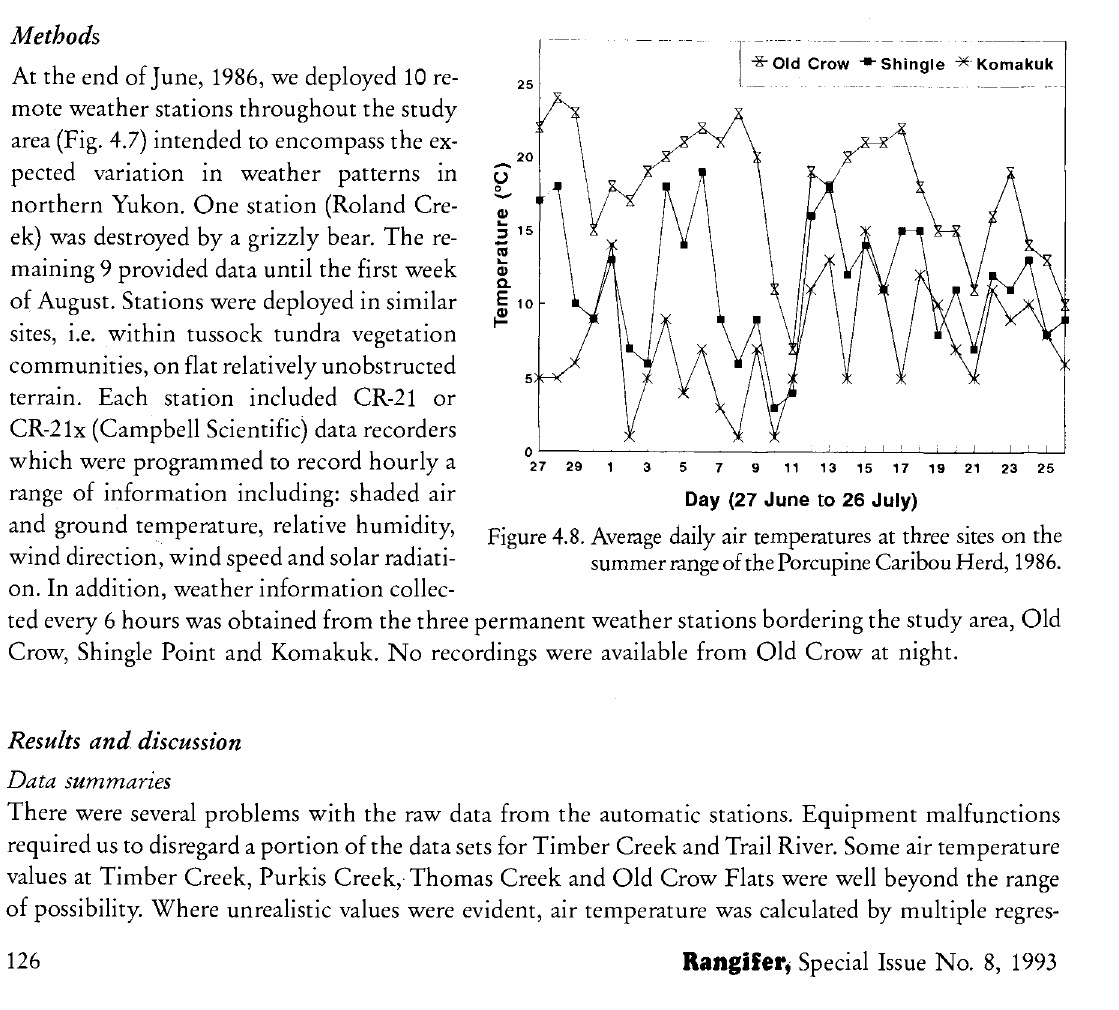
Figure 4.8. Average daily air temperatures at three sites on the summer range of the Porcupine Caribou Herd,